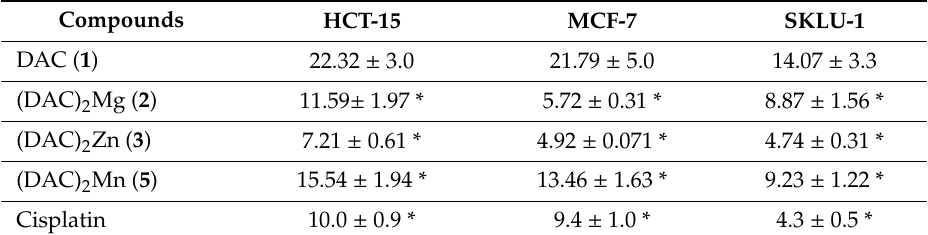
Table 9. IC 50 ( µ M) for cancer cell lines with compounds 1 , 2 , 3 , 5 and cisplatin.